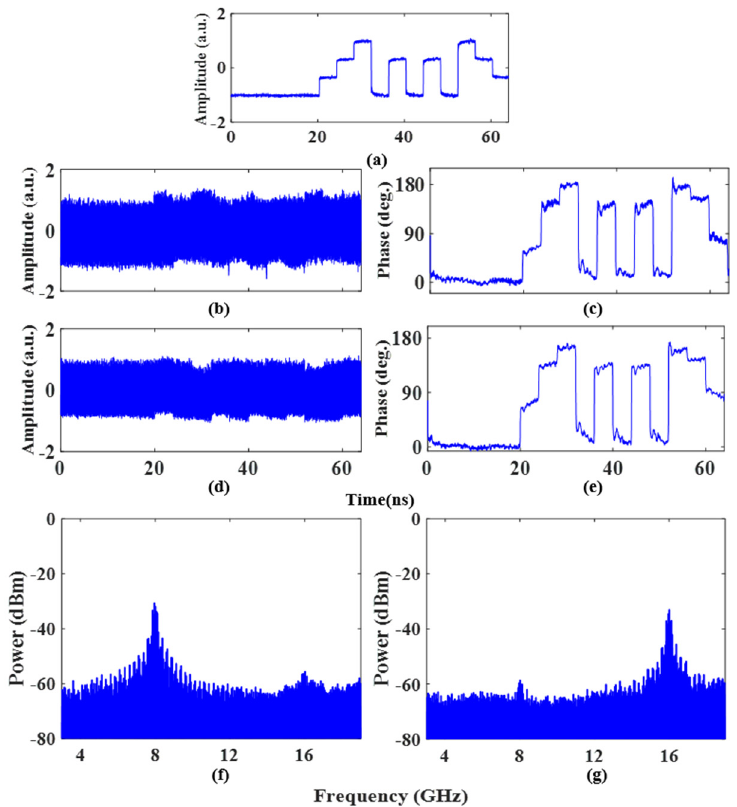
Figure 10. ( a ) The waveform diagram of the original coding signal; ( b ) the waveform and ( c ) the recovered phase of the quaternary phase-coded signal in the fundamental carrier frequency mode; ( d ) the waveform and ( e ) the recovered phase of the quaternary phase-coded signal in the doubled carrier frequency mode; and the electrical spectra corresponding to the fundamental frequency mode ( f ) and the doubled frequency mode ( g ).